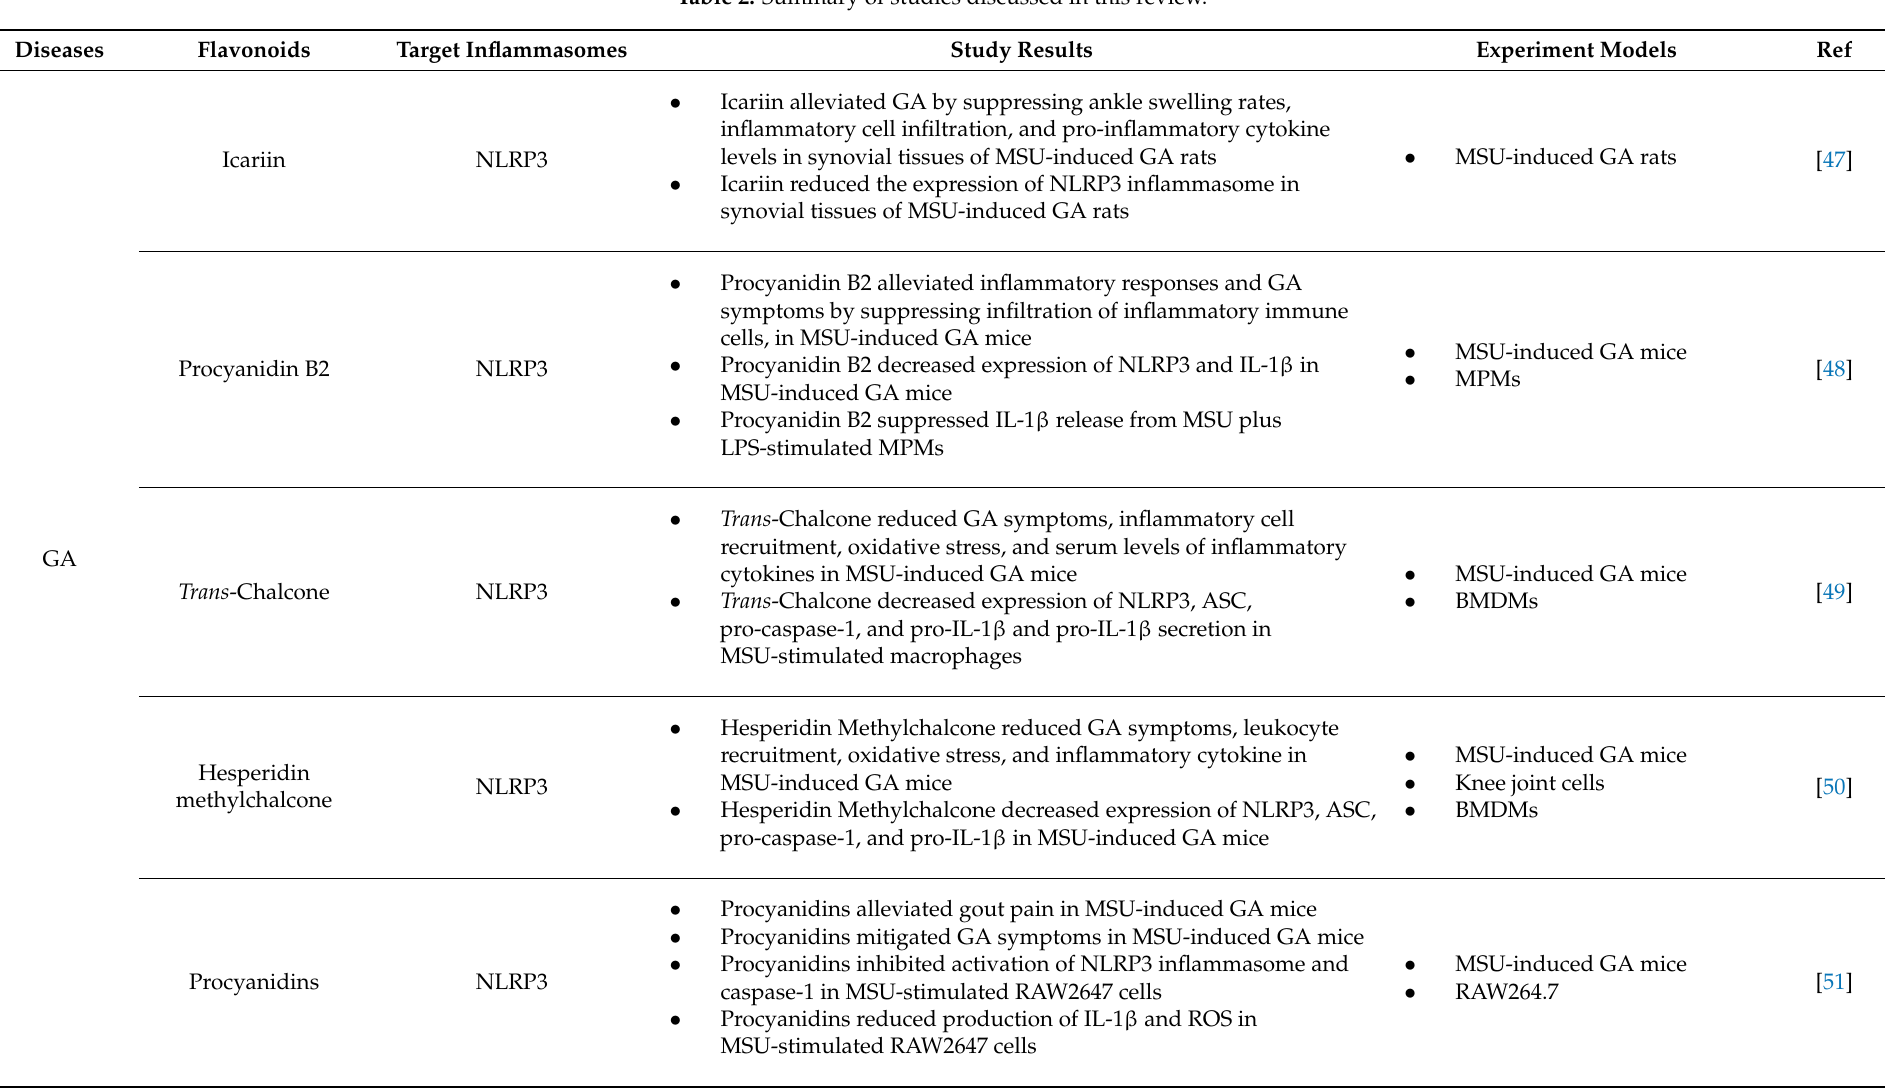
Table 2. Summary of studies discussed in this